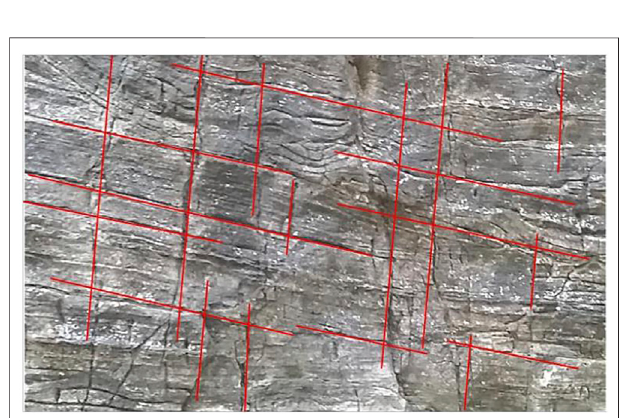
FIGURE 13 | The nature fracture